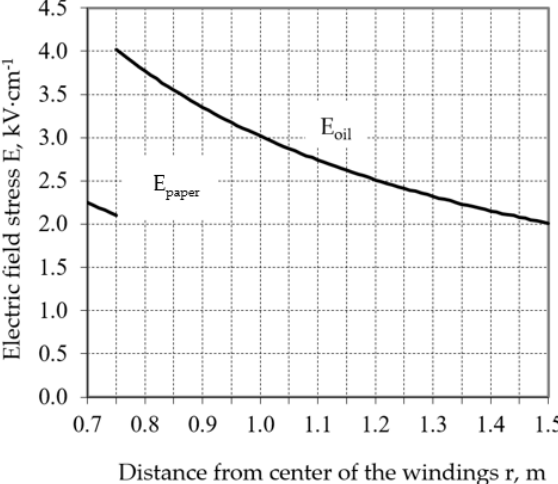
Figure 2. Electric field stress E inside the transformer insulation between the winding and the tank (paper insulation: 0.70 ÷ 0.75 m, electrical insulating liquid: 0.75 ÷ 1.50 m, U = 220 kV).